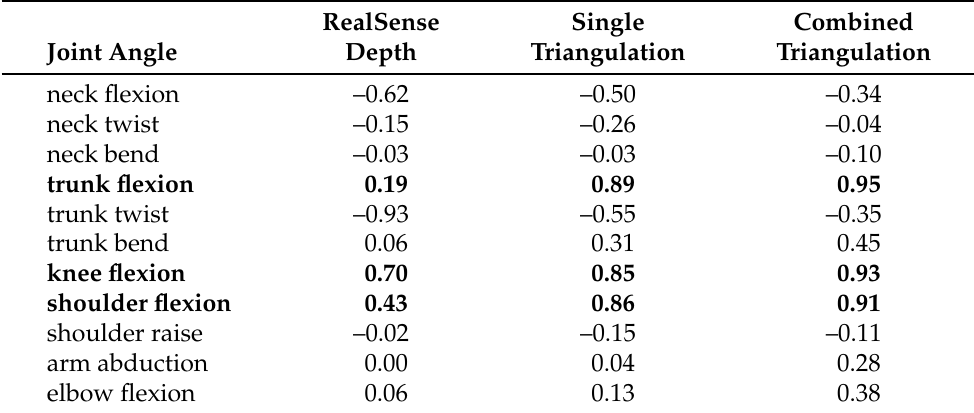
Table 1. R 2 values for joint angles calculated using different methods. The three key angles and their values are shown in bold font.